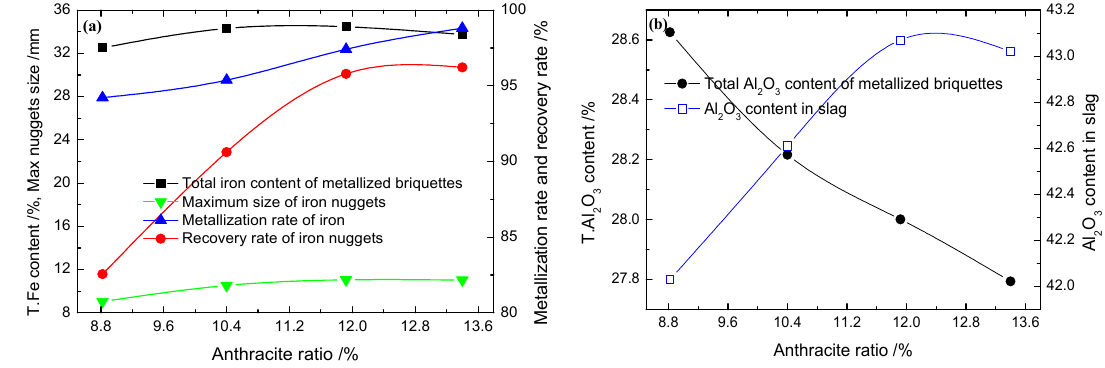
Figure 10. Effect of anthracite ratio on the ( a ) reduction indexes and ( b ) Al 2 O 3 grade.